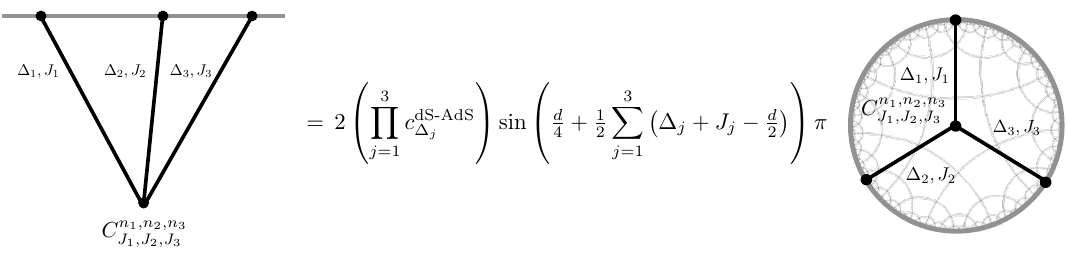
Figure 15. The sinusoidal factor relating spinning three-point diagrams in dS and EAdS depends on the spins of the fields, but it is insensitive to the choice of vertex C n 1 ,n 2 ,n 3 all vertices involving fields with spins J 1 - J 2 - J 3